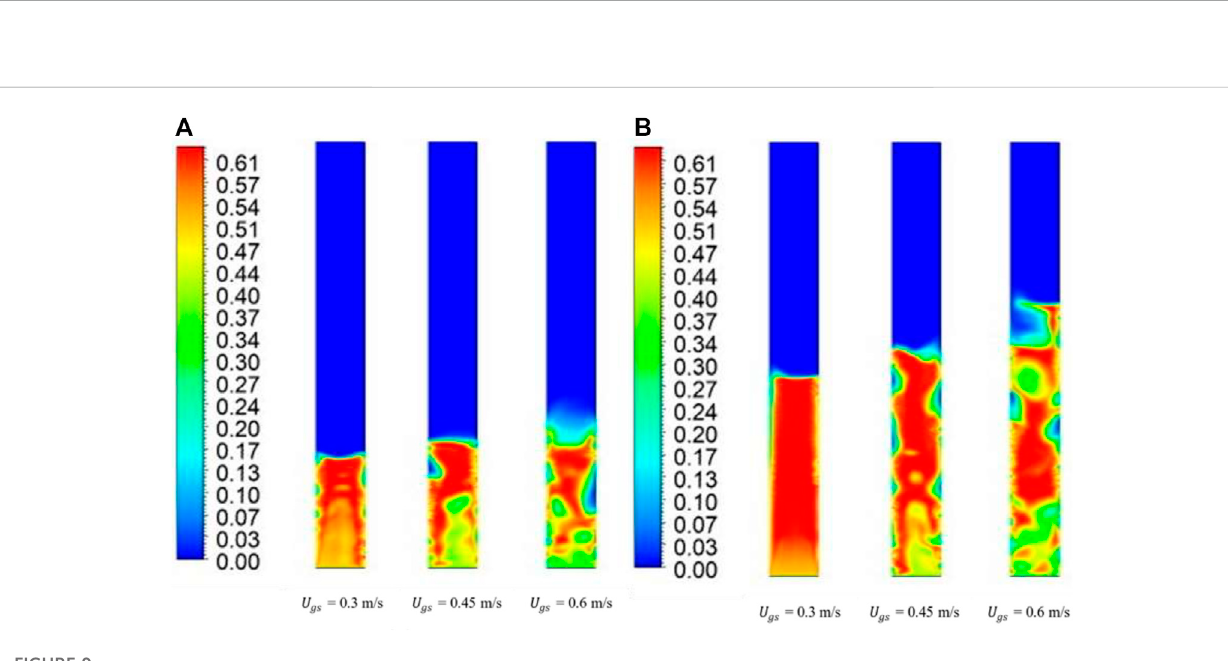
Figure 8 shows the time-averaged steady state solid phase volume fraction contours for a binary mixture of 40% large particles and 60% small particles. Figure 8A shows that, for a lower bed height, there was complete segregation of fl otsam and jetsam. However, mixing was observed when the super fi cial gas velocity was increased ( U gs = 0.45 m/s), and complete segregation did not take place. With further increase in super fi cial gas velocity ( U gs = 0.6 m/s), the following characteristics were observed: bubbles occupied the top area, while fi ner particles were restrained to the middle of the bed, and the top of the bed consisted of mixed particle sizes. The bottom of the bed consisted mostly of jetsam, which denotes intermediate